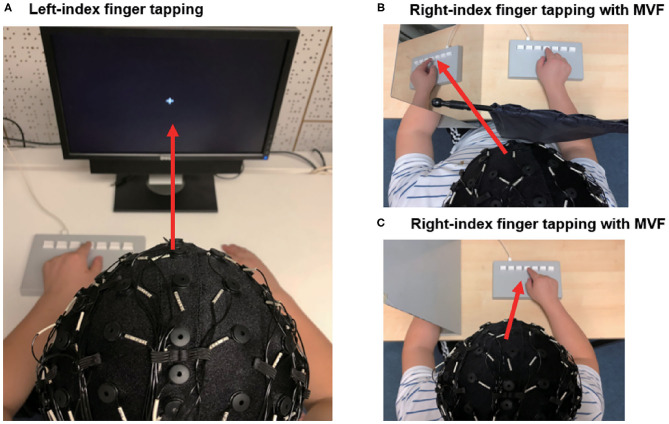
Setup of the EEG experiment. (A) Participants performed left-index finger tapping in response to auditory cues. Participants were instructed to focus on a fixation cross. (B) Participants performed right-index finger tapping in response to auditory cues. Participants were instructed to observe the mirror visual feedback of their moving index finger. A black curtain was used to block the direct view of their moving hand (C) Participants performed right index tapping in response to auditory cues. Participants were instructed to observe their moving index finger. The red arrows represent the visual direction during the movement.